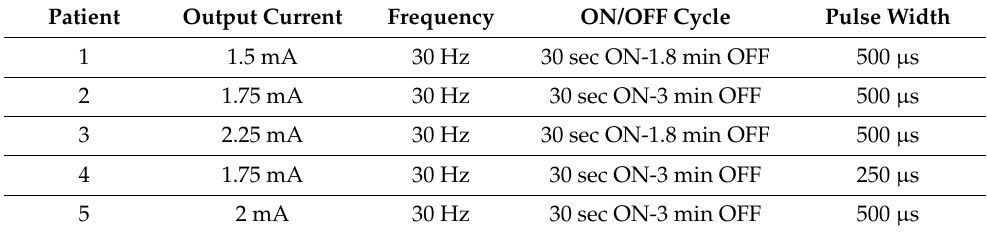
Table 4. Stimulation parameters at last follow-up.